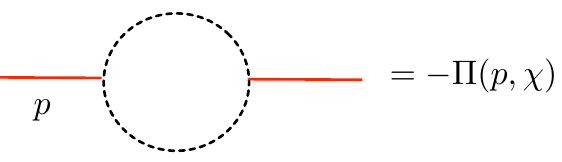
Figure 6 . The polarization loop, which gives the function (cid:5)( p; (cid:31) ) introduced in (2.56).